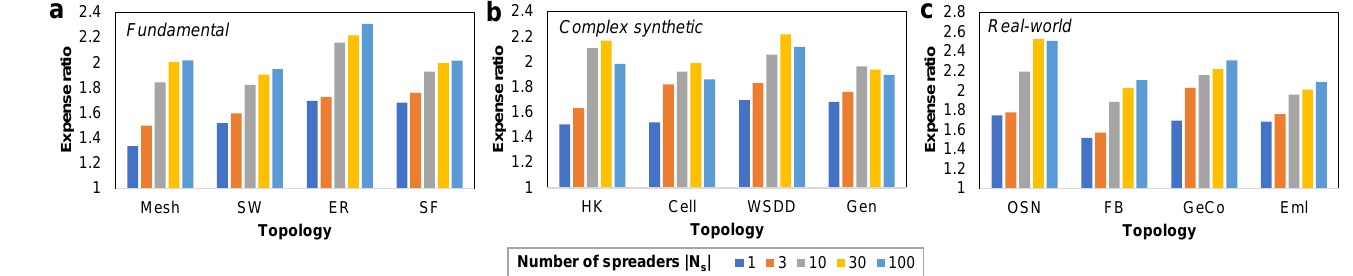
Figure 4. The impact of each network topology on the expense ratio between the continuous and periodic injection strategies is shown in association with an increasing number of spreaders: ( a ) fundamental networks—the Mesh and SW show similar increases in the expense ratio, while the ER and SF networks suggest higher expense ratios; ( b ) complex synthetic networks—the WSDD shows a higher expense ratio, along with HK for a higher number of spreaders; ( c ) real-world networks—the FB and Eml networks yield the lowest expense ratios.